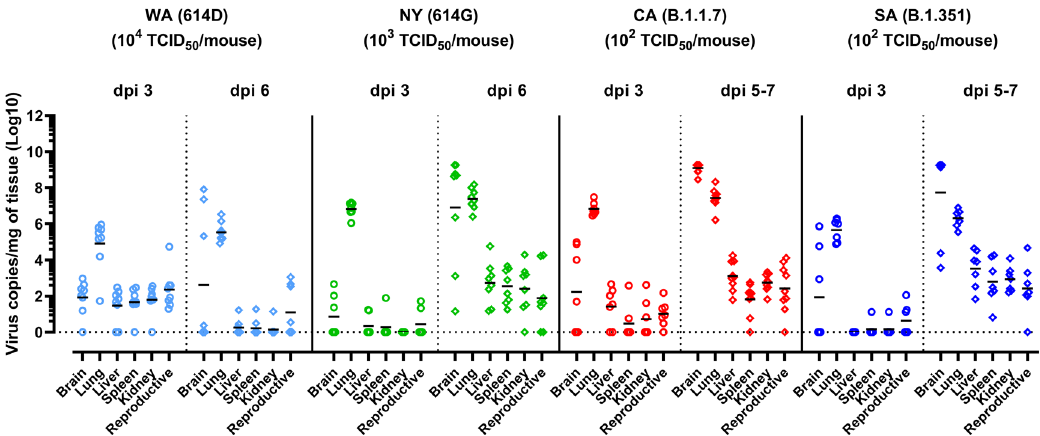
Fig. 3 Viral burden in various organs of K18-hACE2 mice after infections of SARS-CoV-2 and variants. K18-hACE2 mice of both sexes (~1:1 ratio) were infected intranasally with USA-WA1/2020 (WA) of lineage A bearing 614D, New York-PV09158/2020 (NY) of lineage B.1.3 bearing 614G, USA/ CA_CDC_5574/2020 (CA) of lineage B.1.1.7 or hCoV-19/South Africa/KRISP-EC-K005321/2020 (SA) of lineage B.1.351 at indicated doses in an ABSL-3 biocontainment. Viral RNA copies in brain, lung, liver, spleen, kidney, and reproductive organs (ovary or seminal vesicles) at indicated days post infection (dpi) were measured by RT-qPCR. Results combining two independent experiments are shown. Short lines represent geometric means of 7 – 9 mice/time point/group (WA (614D): n = 8 mice/time point/group for dpi 3 and dpi 6; NY (614G): n = 7 mice/group for dpi 3 and n = 8 mice/time point for dpi 6; CA (B.1.1.7): n = 7 mice/group for dpi 3 and n = 9 mice/group for dpi 5 – 7; SA (B.1.351): n = 7 mice/time point/group for dpi 3 and dpi 5 – 7). Dotted horizontal line indicates the limit of